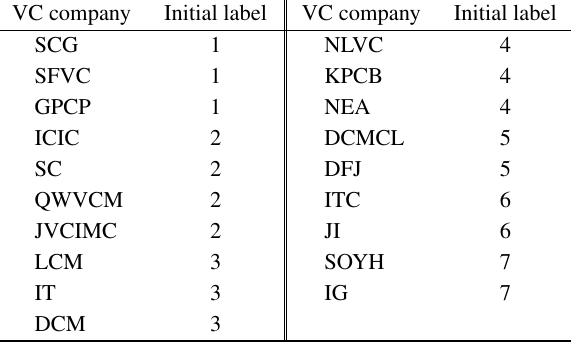
Table 2 Initial labels designed according to the cluster situation of 42 VC industry